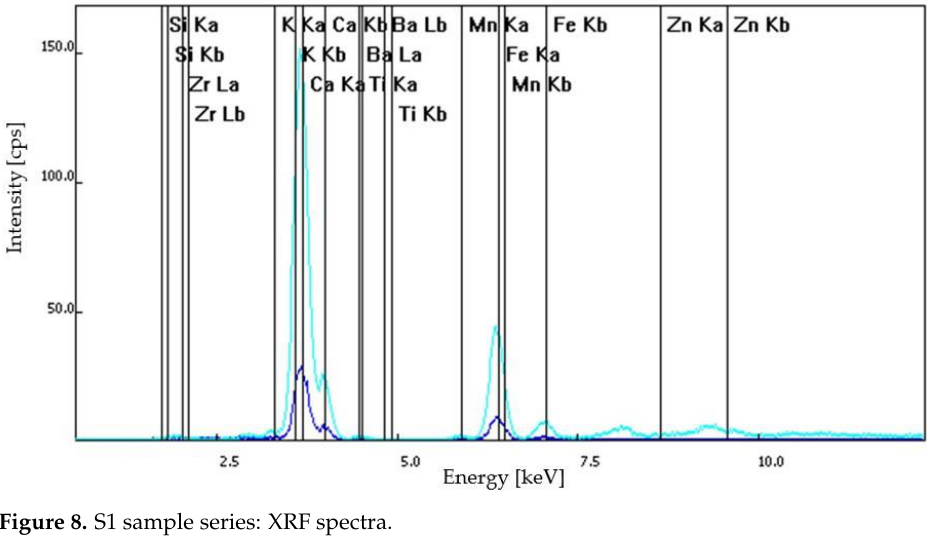
Figure 8. S1 sample series: XRF spectra.